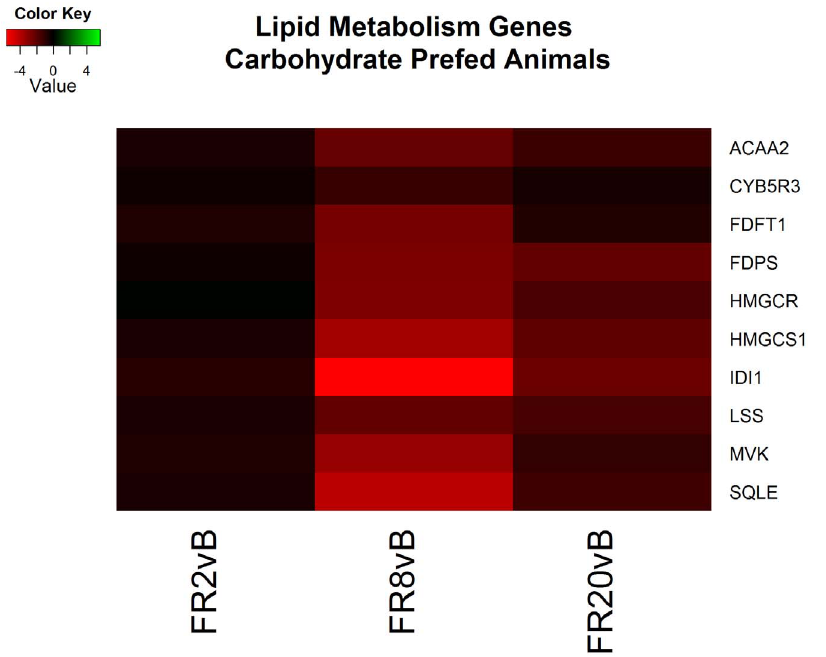
Figure 5. Heatmap of log2 fold changes of genes associated with lipid metabolism in carbohydrate prefed (CPF) animals at each resuscitation timepoint (2, 8, and 20 hours) relative to Baseline (B). Rows are differentially expressed genes (DEGs) following RNA sequencing. Columns denote the respective timepoints Baseline (B), 2 hours full resuscitation change from Baseline (FR2vB), 8 hours full resuscitation change from Baseline (FR8vB), and 20 hours full resuscitation change from Baseline (FR20vB). Green denotes increased mRNA expression with respect to Baseline whereas red denotes the opposite.